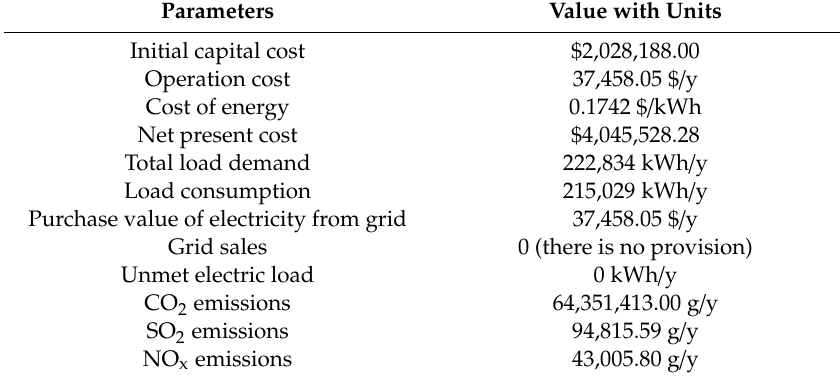
Table 6. Techno-economic and environmental indicators of EG + BES based power supply